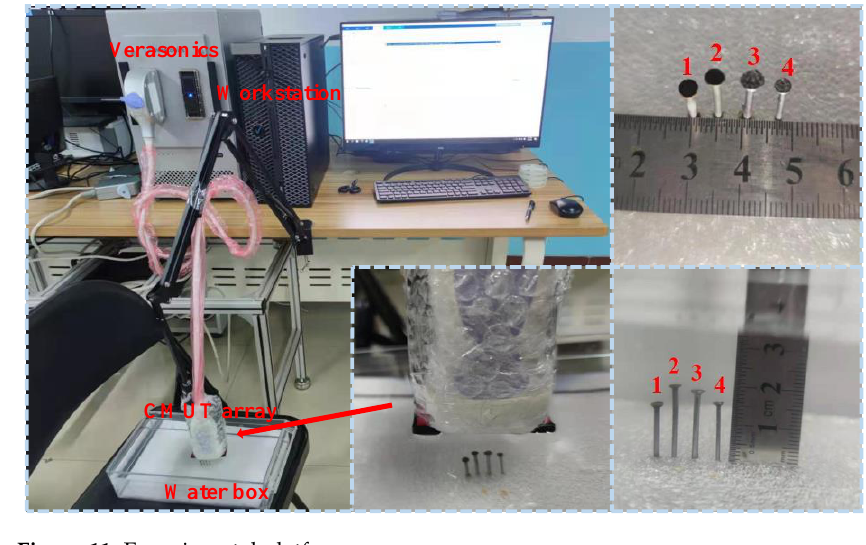
Figure 11. Experimental platform.